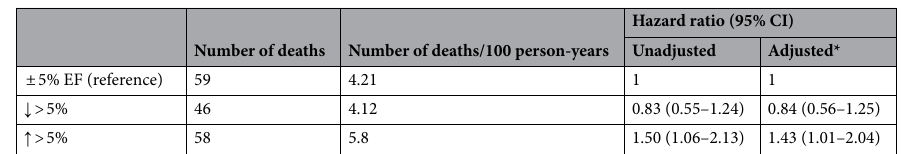
Number of deaths Number of deaths/100